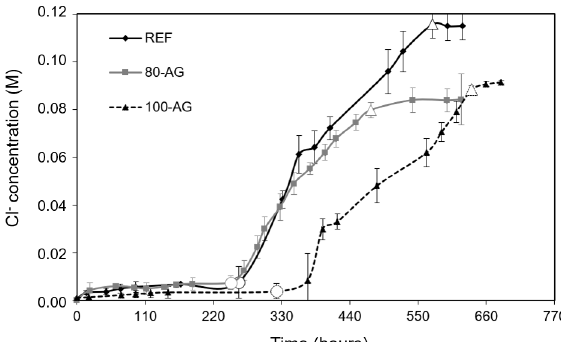
Figure 10. Chloride concentration in the anodic cell solution as a function of time for the concrete specimens with different mortar content (○ = beginning of steady state and Δ = end of steady